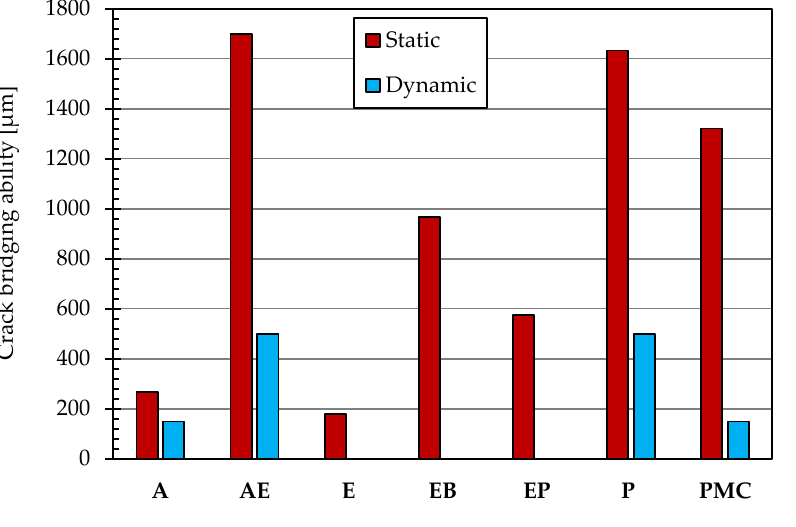
Figure 4. Crack-bridging test results.